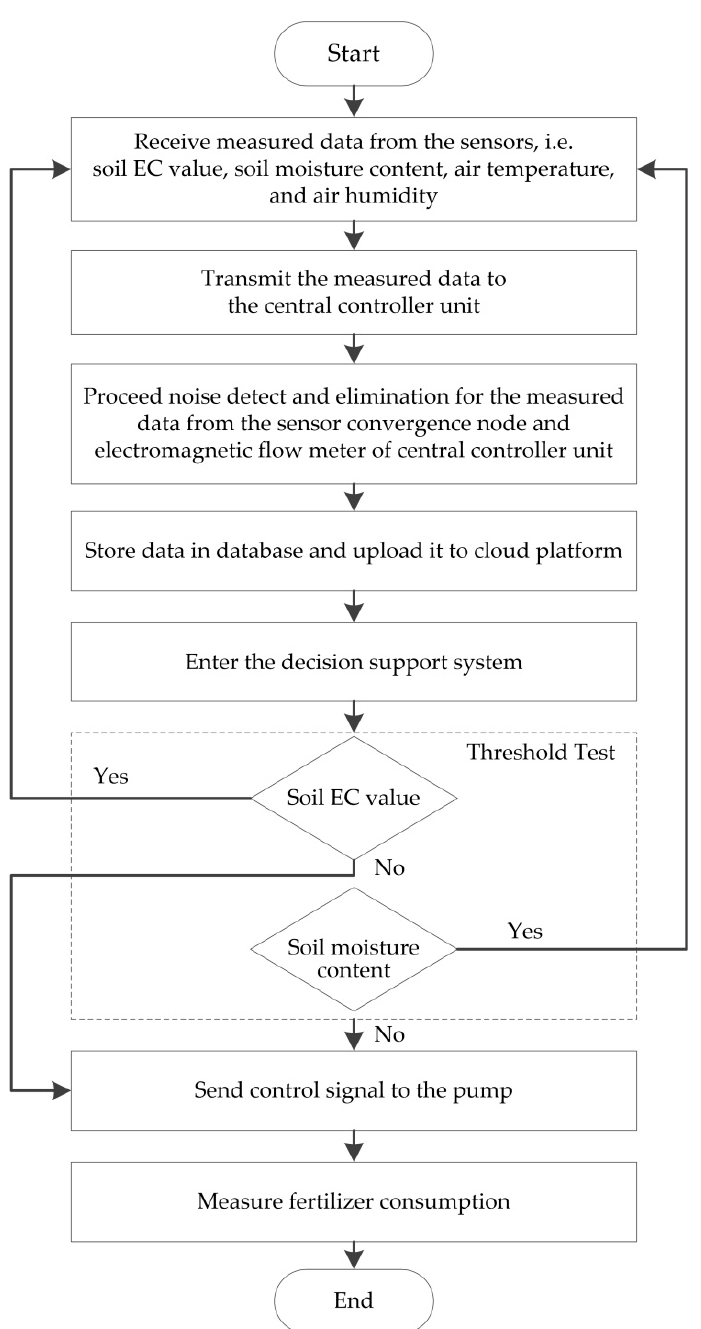
Figure 3. The workflow of the proposed water-fertilizer control system.